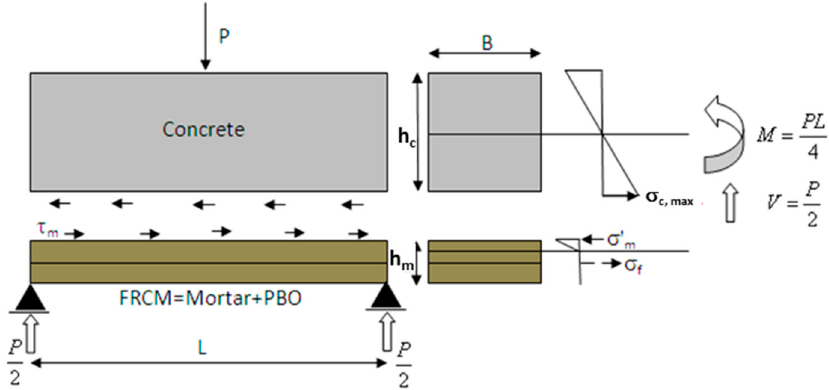
Figure 5. Theoretical model: zero friction slipping hypothesis.